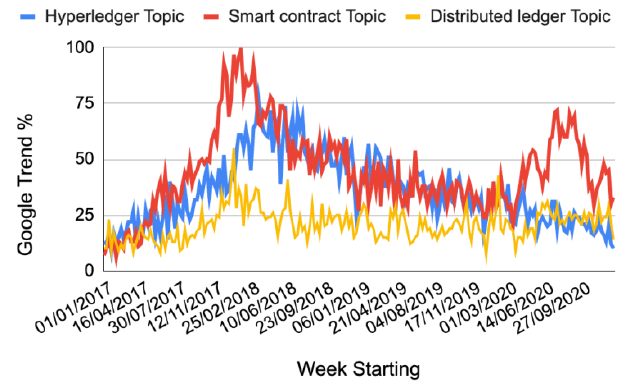
Figure 15: Google topic trend results for ‘Hyperledger’, ‘Smart contract' and 'Distributed